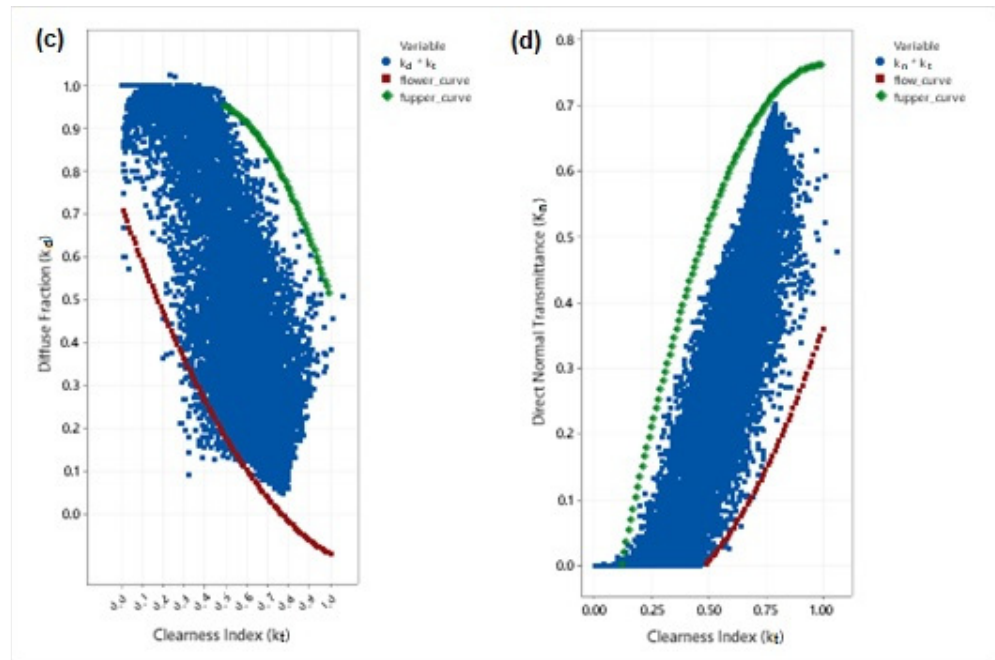
Figure 9. Scatter plot of 10-min values in: ( a ) k d - k t space and ( b ) k n - k t space and limits for quality control tests. Scatter plot of 10-min values in ( c ) k d - k t space and ( d ) k n - k t space and limits for quality control tests.